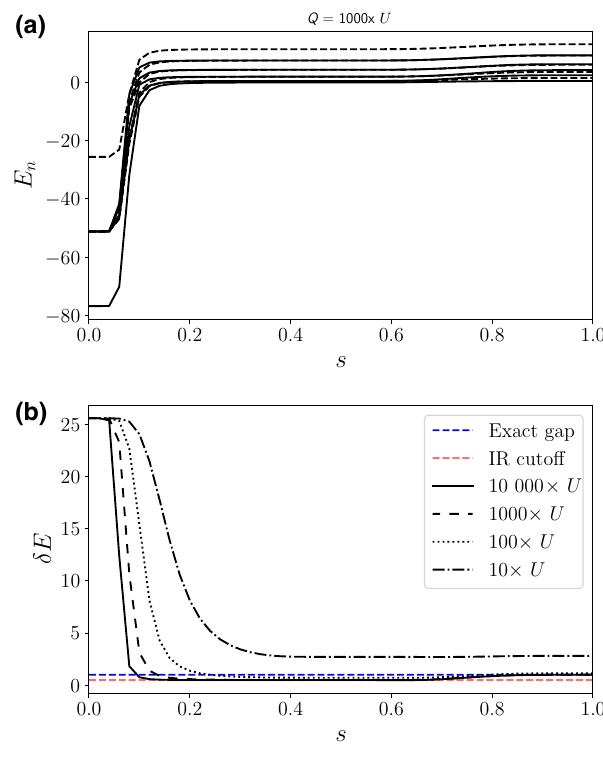
FIG. 11. (a) The time-dependent energy spectrum of H ( s ) of the first ten states for a system of eight qubits. The solid lines denote even-numbered states (0, 2, 4, 6, 8), and dashed lines label odd-numbered states (1, 3, 5, 7, 9). (b) The time-dependent energy gap between the first excited state and ground state as a function of evolution time s and strength of the penalty coeffi- cient Q . The dotted, dashed, and solid lines denote progressively stronger penalty coefficients, set relative to the U scale. The dashed red line is calculated from Eq. (25), yielding the infrared